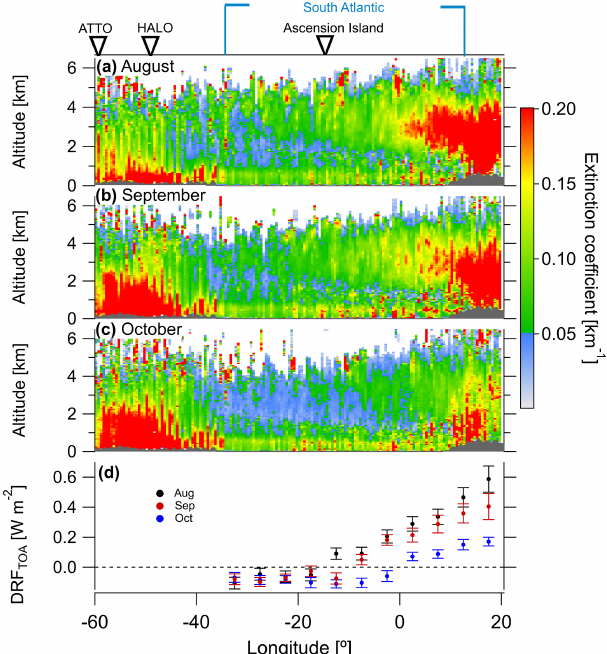
Figure 10. Curtain plot showing the columnar aerosol extinction coefficient at 532nm, based on multi-year CALIOP data from 2012 to 2018 (only nighttime data). Panels represent monthly averages for the months of (a) August, (b) September, and (c) October within the latitude band from 10 ◦ S to 5 ◦ N, corresponding to the ROI indi- cated in Fig. 7a 1 . The grey shaded area represents the mean surface elevation and depicts boundaries of the African and South Ameri- can continents. Panel (d) shows the daily mean of the direct radia- tive forcing at the top of the atmosphere (DRF-TOA) exerted by the pollution layer over the South Atlantic Ocean, calculated using the LibRadTran radiative transfer